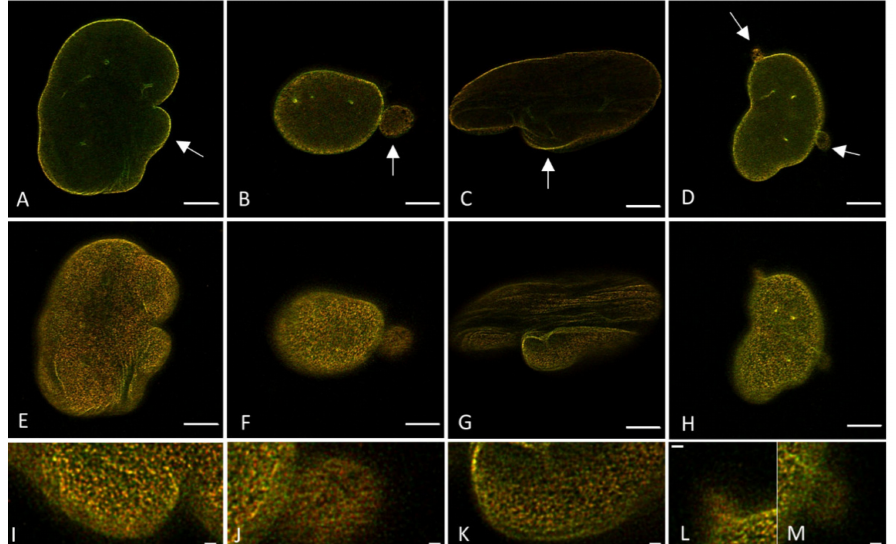
Figure 10. Laminopathy patient dermal fibroblasts with an LMNA c.1130G>T (p.(Arg377Leu)) variant, stained with antibodies against lamin A/C and lamin B1, imaged with STED microscopy. ( A – D ) Merged image of lamin A/C (red) and lamin B1 (green), mid-level of the nucleus. Arrows: typical laminopathy cell aberrations. ( E – H ) Merged image of lamin A/C (red) and lamin B1 (green), top of the nucleus. ( I – M ) Higher magnification (3 × ) of lamin aberrations in ( E – H ). Scale bars: 5 µ m.